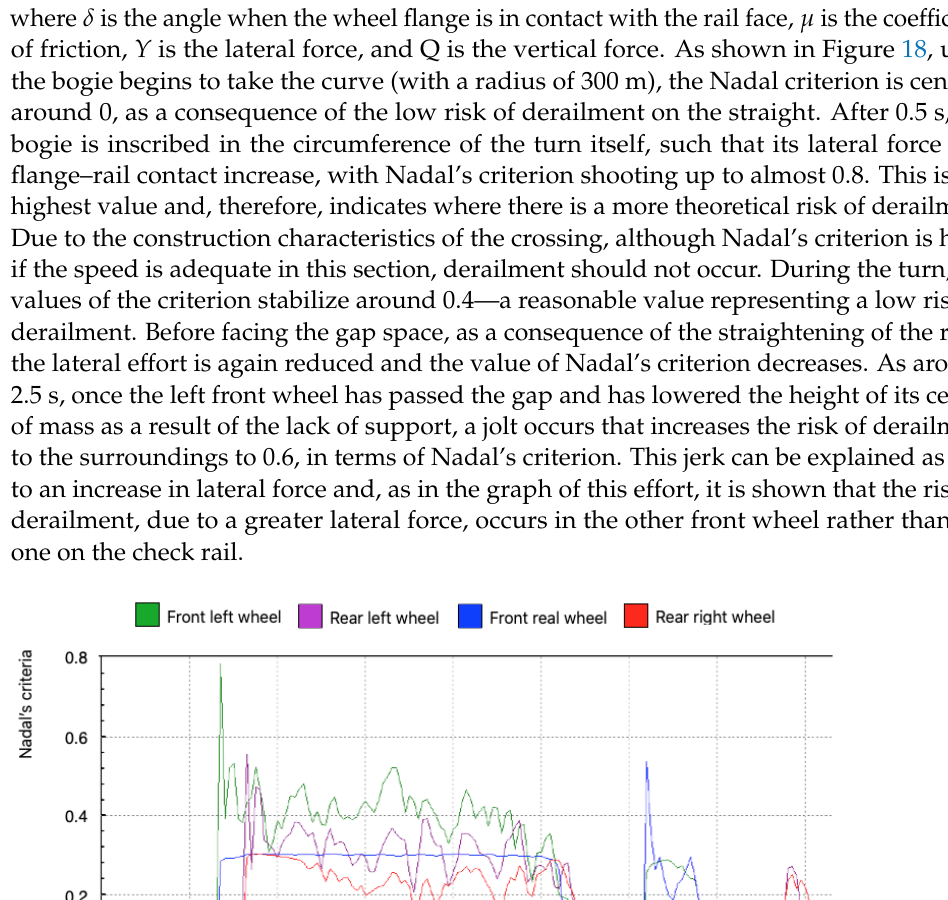
( b ) Figure 19. Forces in the wheel – rail contact and their position in the right turn: ( a ) Left wheel; and ( b ) right wheel. However, when it crosses the intersection (Figure 20), the wheel that compromises safety due to a greater risk of derailment is the wheel that circulates along the rail outside